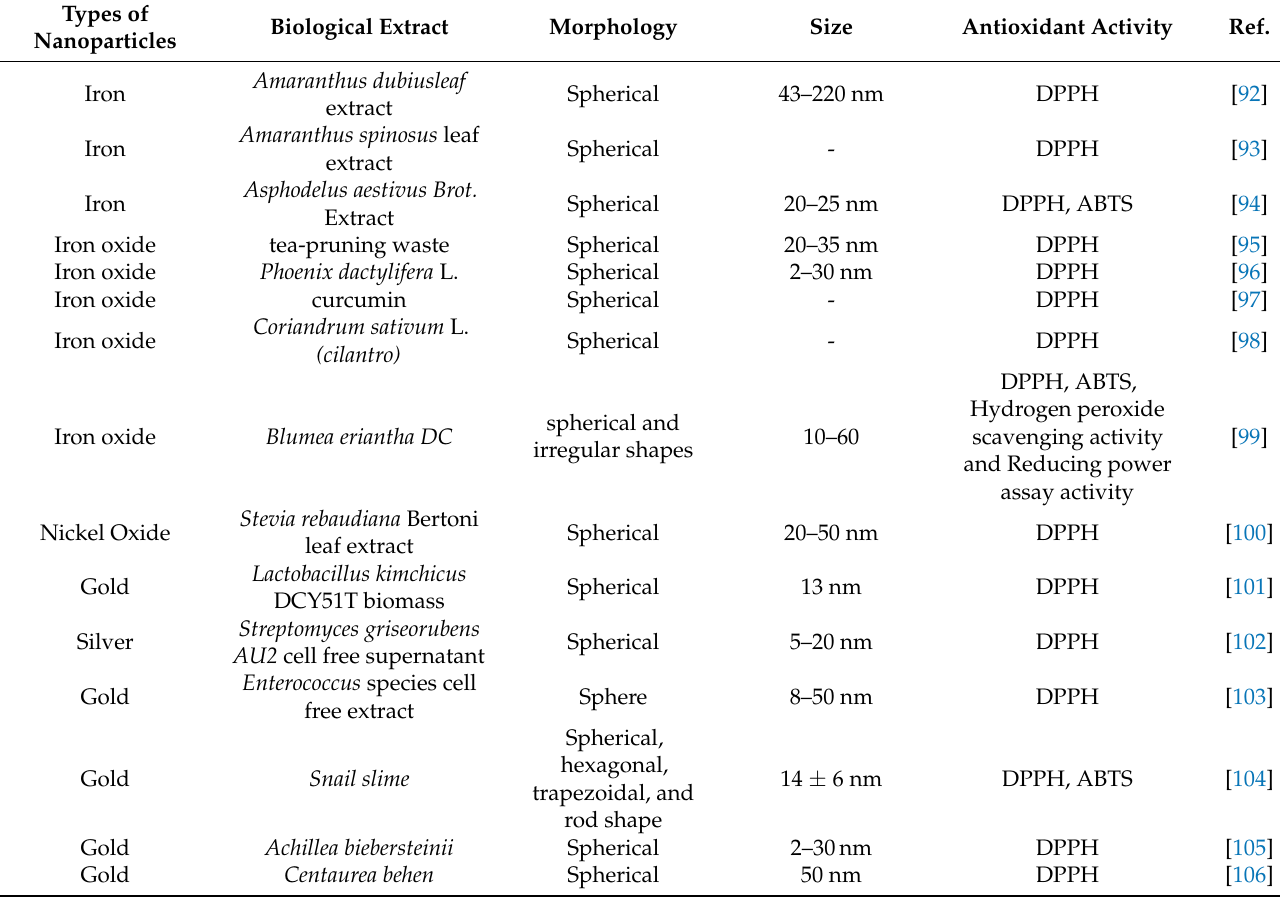
Table 2. Nanoparticles with Antioxidant